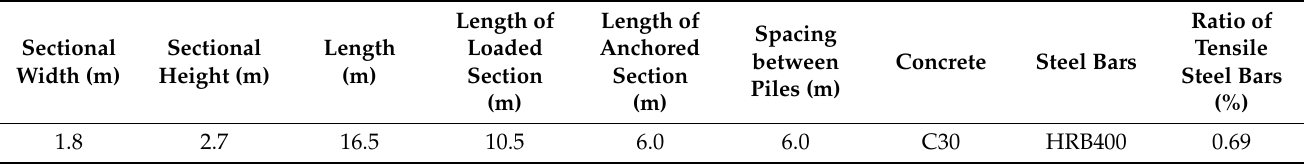
Table 1. Basic parameters of the actual cantilever anti-slide pile.